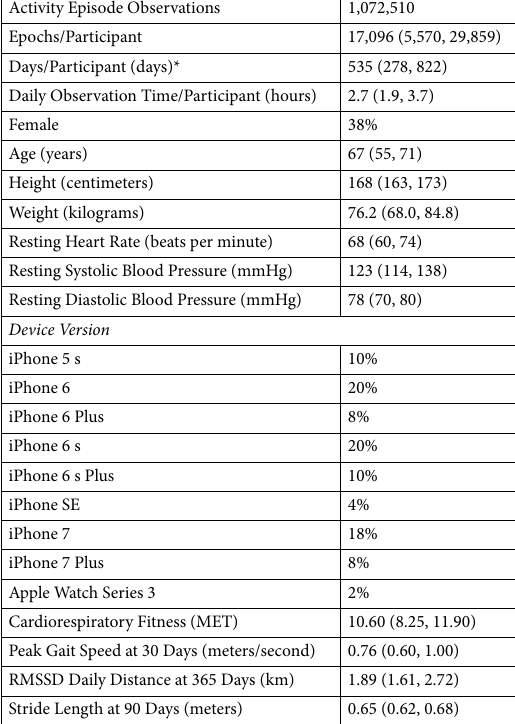
Table 1. Baseline characteristics of study population ( N = 50). Baseline characteristics of study population including median (Interquartile range) for continuous variables and percentage for categorical variables.